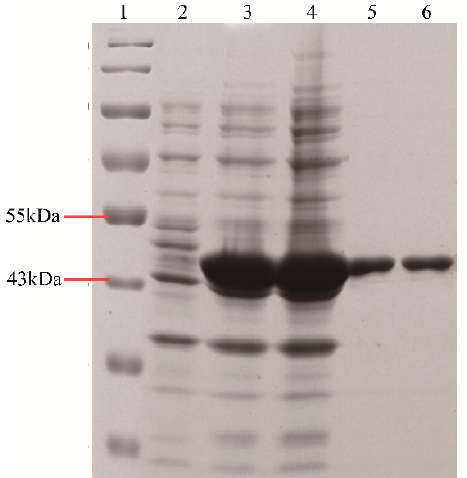
Figure 2. Expression and purification of the recombinant BsGT1 and BsGT2 . 1, protein marker; 2, the lysate of E. coli with empty plasmid pET-28a (+); 3, soluble protein of recombinant BsGT1 after induction; 4, soluble protein of recombinant BsGT2 after induction; 5, purified recombinant BsGT1 ; and, 6, purified recombinant BsGT2 .